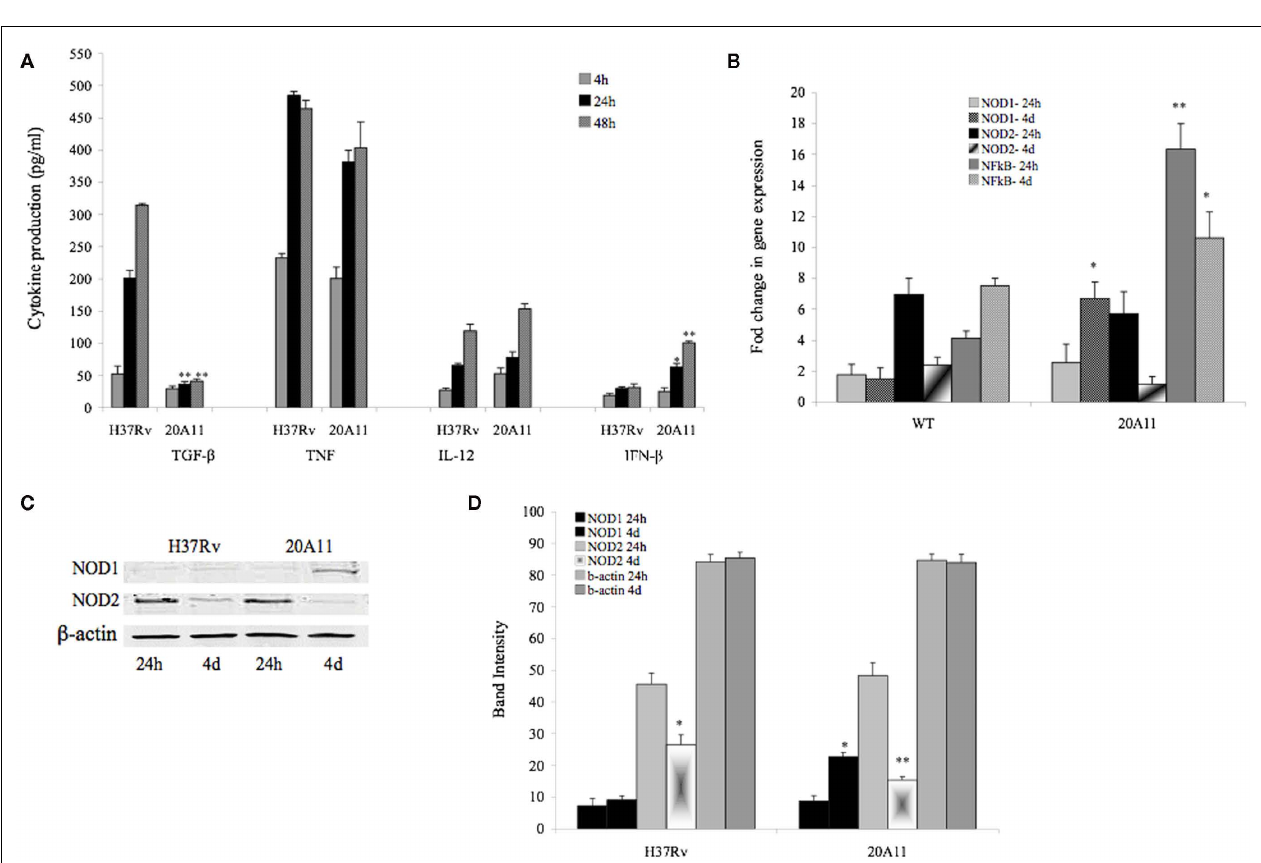
between the 20A11 mutant and H37Rv strain was evaluated * p < 0.05 and ** p < 0.01 at the same times of post-infection. (C) Western blot analysis of NOD1 and NOD2 proteins. U937 cells were infected with M. tuberculosis H37Rv or 20A11 mutant (MOI 1:10) and cultured for 24h and 4days. Immunoprecipitated cell lysates were subjected toWestern blotting, as described in Section “Materials and Methods.” (D) NOD1, NOD2 and β -actin protein levels were quantified via semi-quantitativeWestern blot analysis on the Li-Cor Odyssey Platform.The data represent the average of three independent experiments ± SD. A * p < 0.05 for NOD1 and NOD2 protein levels at day 4 compared with 24h post-infection with 20A11 and H37Rv, respectively. ** p < 0.01 Difference in NOD2 protein levels at day 4 compared with 24h time post-infection with 20A11